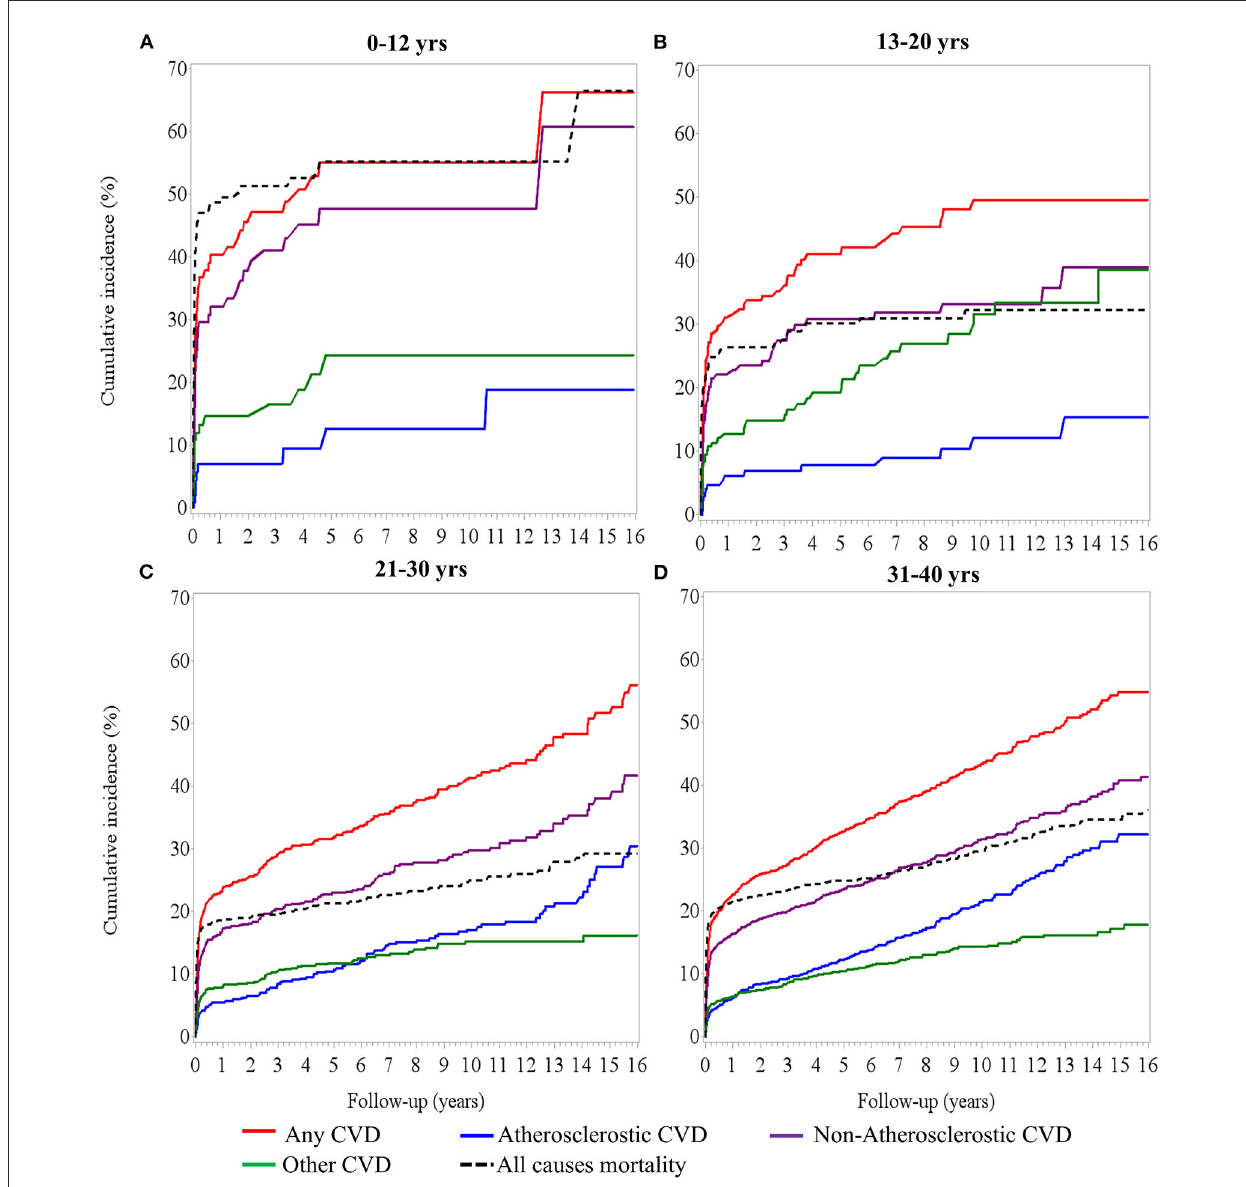
FIGURE1 Cumulative incidence of cardiovascular event and mortality over time in (A) 0–12 years of age, (B) 13–20 years of age, (C) 21–30 years, and (D) 31–40 years of age with dialysis treatment.